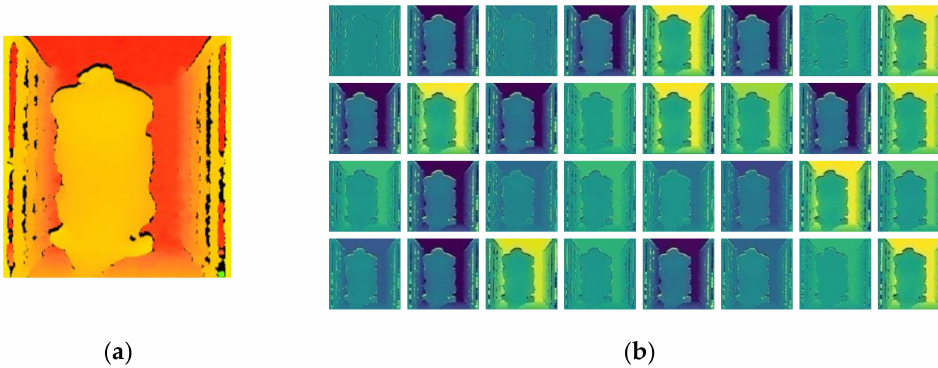
Figure 9. Original image ( a ) and feature maps ( b ) output from the first convolutional layer of modified Xception.